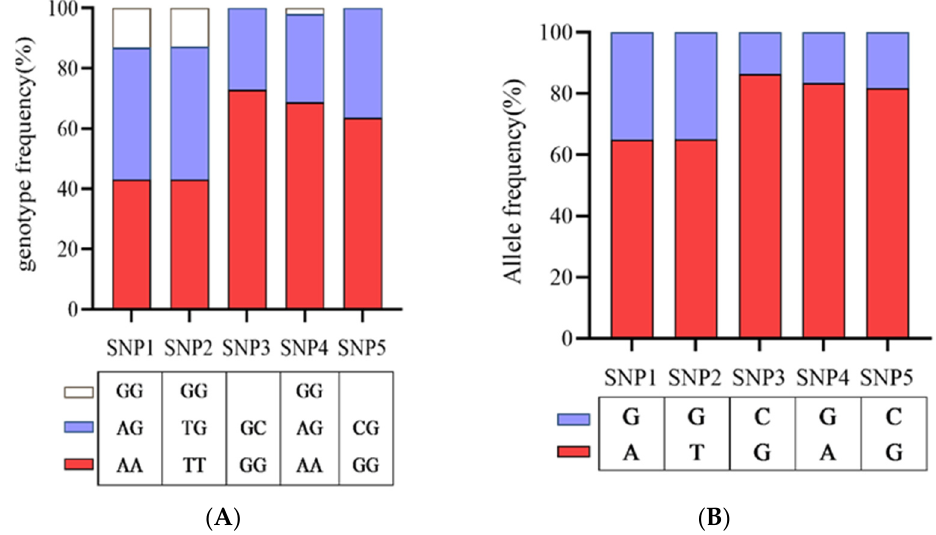
Figure 6. The genotype and allele frequency distribution of GHRb gene SNP loci in the striped catfish population. ( A ). Genotype frequency of five SNP loci, where the blank space indicates that we did not observe the third genotype at this SNP locus. ( B ). Allele frequency of five SNP loci.